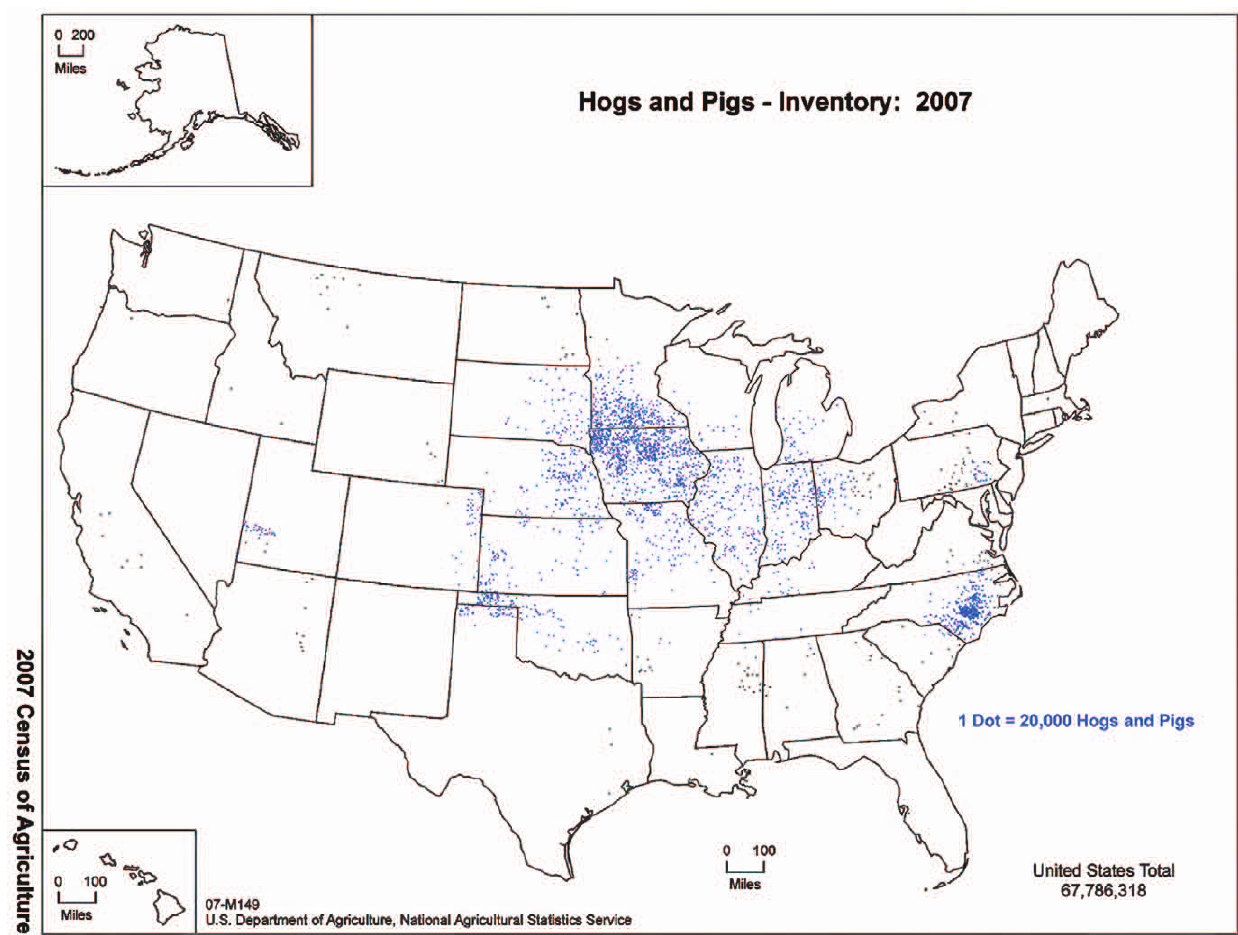
Figure 1. Geographic concentration of hog and pig production in the US. Figure Legend: 2007 Census of Agriculture data from the United States Department of Agriculture (USDA) shows the geographic concentration of hog and pig production in the US. Source: USDA Census of Agriculture; 2007 Census Ag Atlas Maps www.agcensus.usda.gov/Publications/2007/Online_Highlights/Ag_Atlas_Maps/.